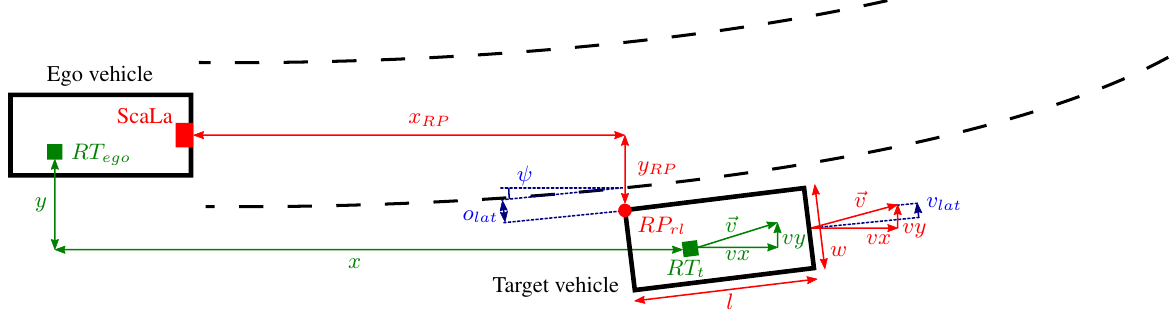
Figure 5: Test setup for performance evaluation. Green variables refer to the reference system and red to the scanner. The blue variables show the desired observations for our algorithm. Not drawn to scale.